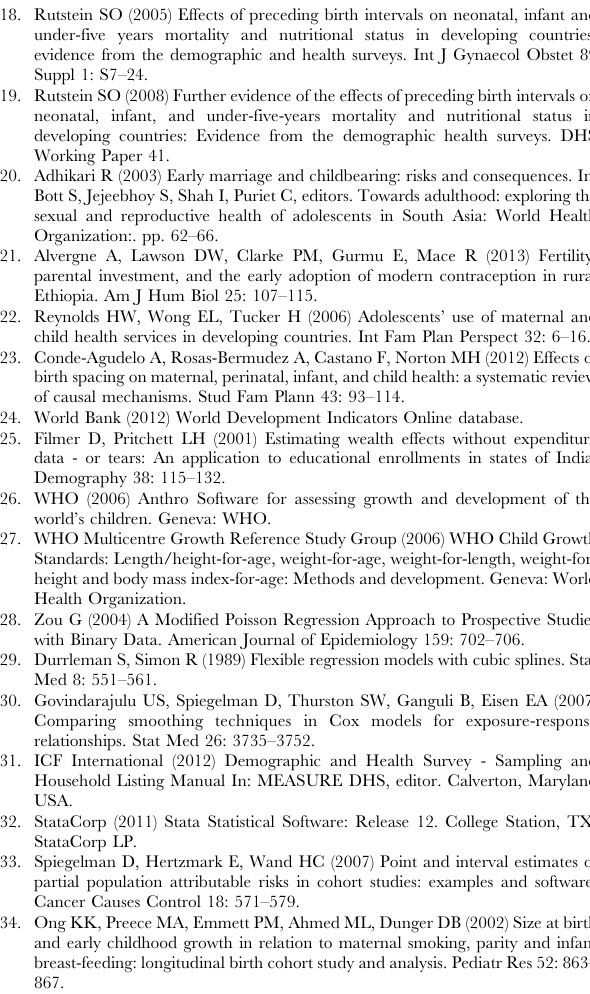
Figure S4: Geographical Coverage of 61 Sample Countries. Figure S5. Crude stunting prevalence for first born children by maternal age. Figure S6. Crude stunting prevalence for first born children by birth